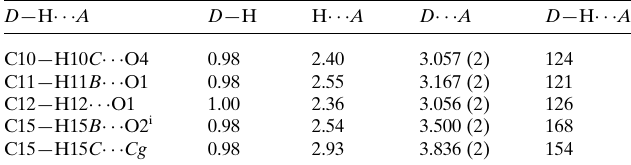
Table 1 Hydrogen-bond geometry (A˚ , (cid:3) ). Cg is the centroid of the C1–C6 aromatic ring.